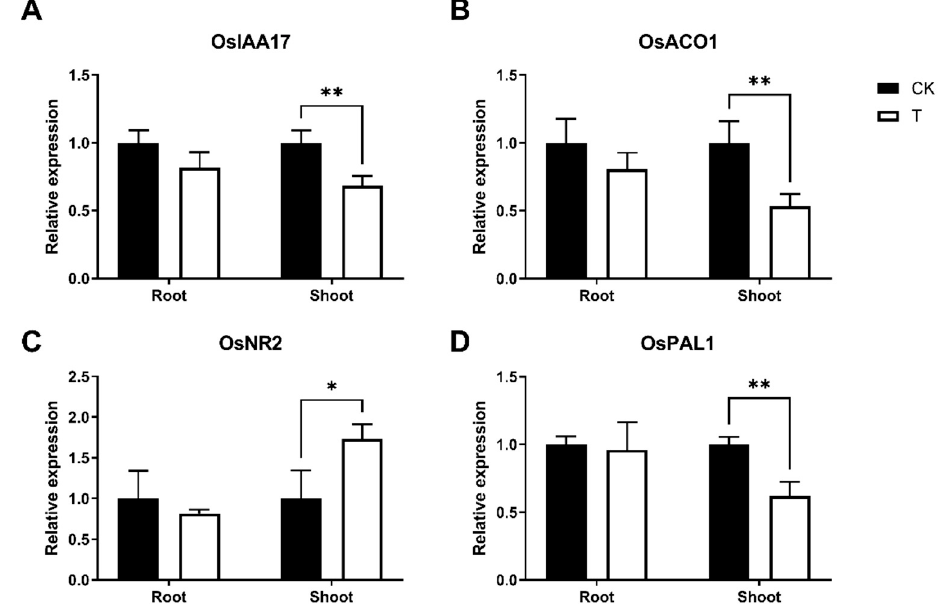
Figure 5. Relative expression of the signaling molecule-related genes OsIAA17 (A), OsACO1 (B), OsNR2 ( C ), and OsPAL1 ( D ) in Cd-N. (Values are means with SD, n = 4, p value style is APA, p > 0.05, OsNR2 (C), and OsPAL1 (D) in Cd-N. (Values are means with SD, n = 4, p value style is APA, ns: p > *: p < 0.05, **: p < 0.05, *: p < 0.05, **: p < 0.01).